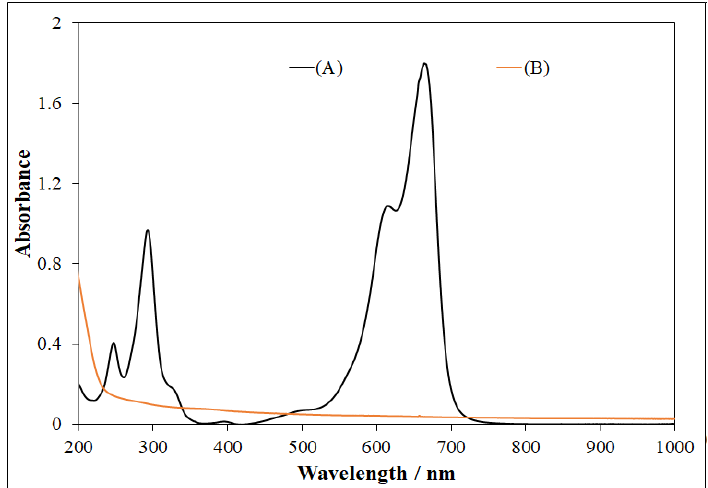
Figure 10. ( A ) Methylene blue spectrum, and ( B ) UV-visible spectrum obtained after MB degradation using NP-3 (Cu II 0.4 Fe II 0.6 Fe III 2 O 4 ). Experimental conditions: concentration of MB = 1.5 × 10 − 5 mol/L, concentration of NPs = 400 mg/L, concentration of H 2 O 2 = 1.76 × 10 −1 mol/L, initial pH = 7.5, and irradiation time = 140 min.